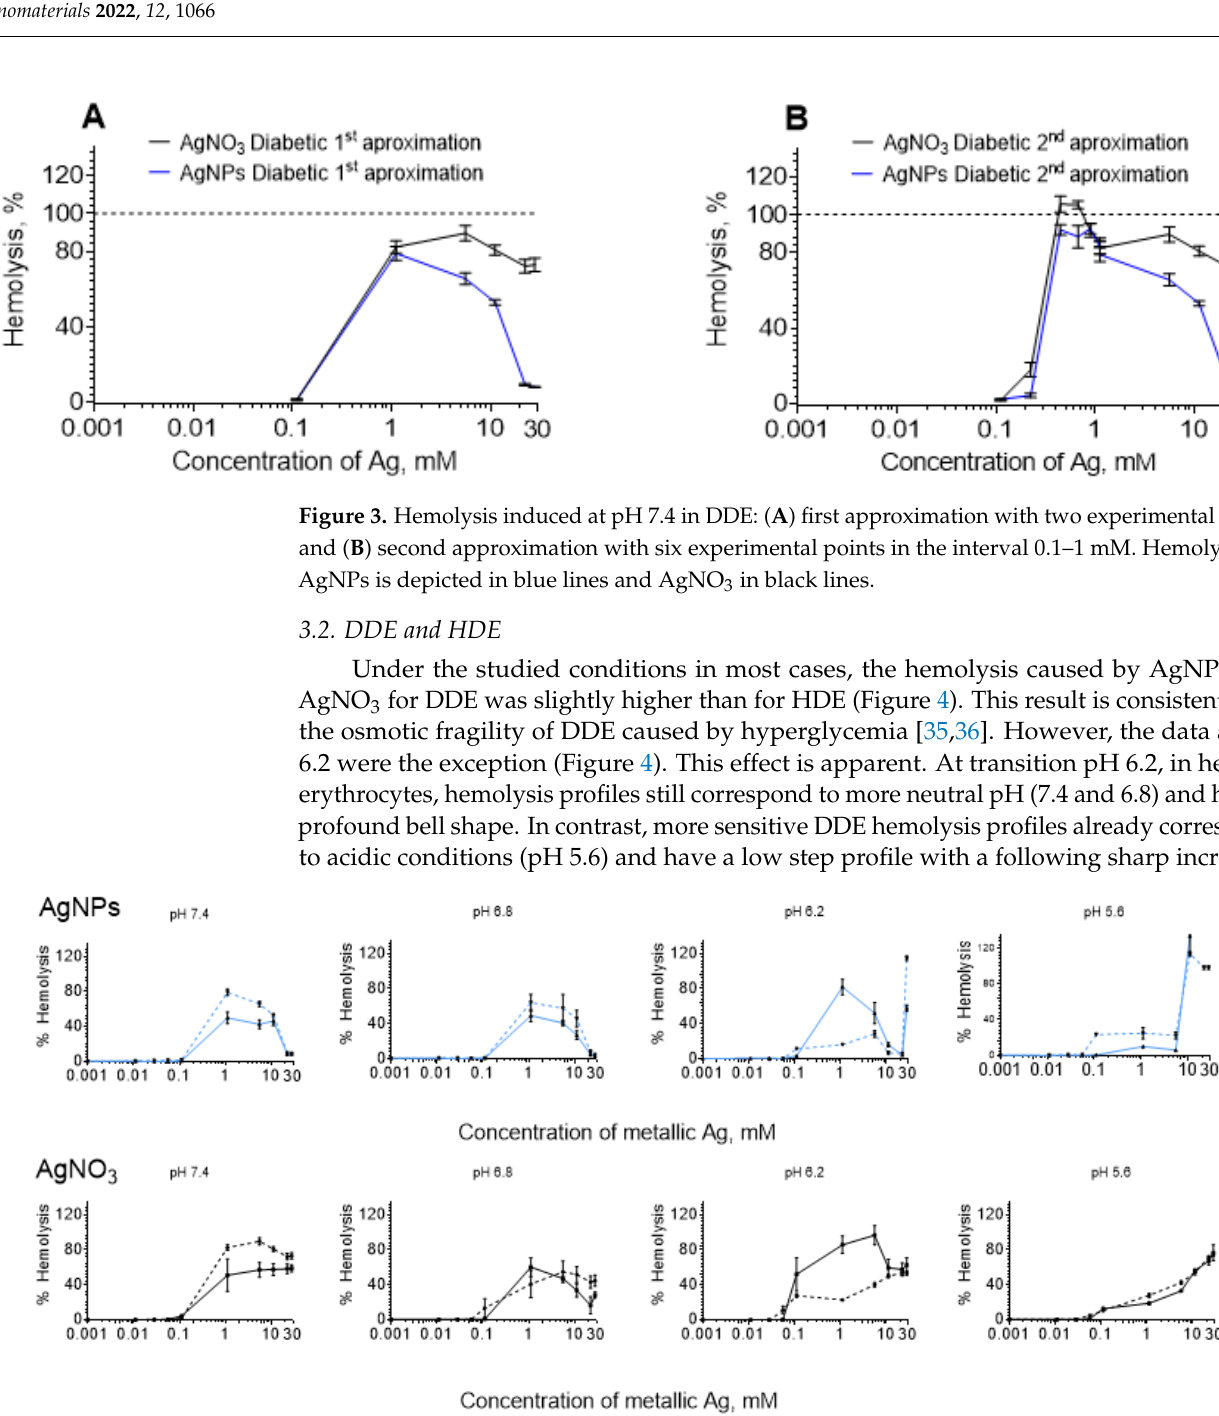
Figure 4. Hemolysis induced by AgNPs at pH 7.4, 6.8, 6.2, and 5.6 in DDE (dotted) and HDE (continuous), blue lines, and AgNO 3 in DDE (dotted) and HDE (continuous), black lines.